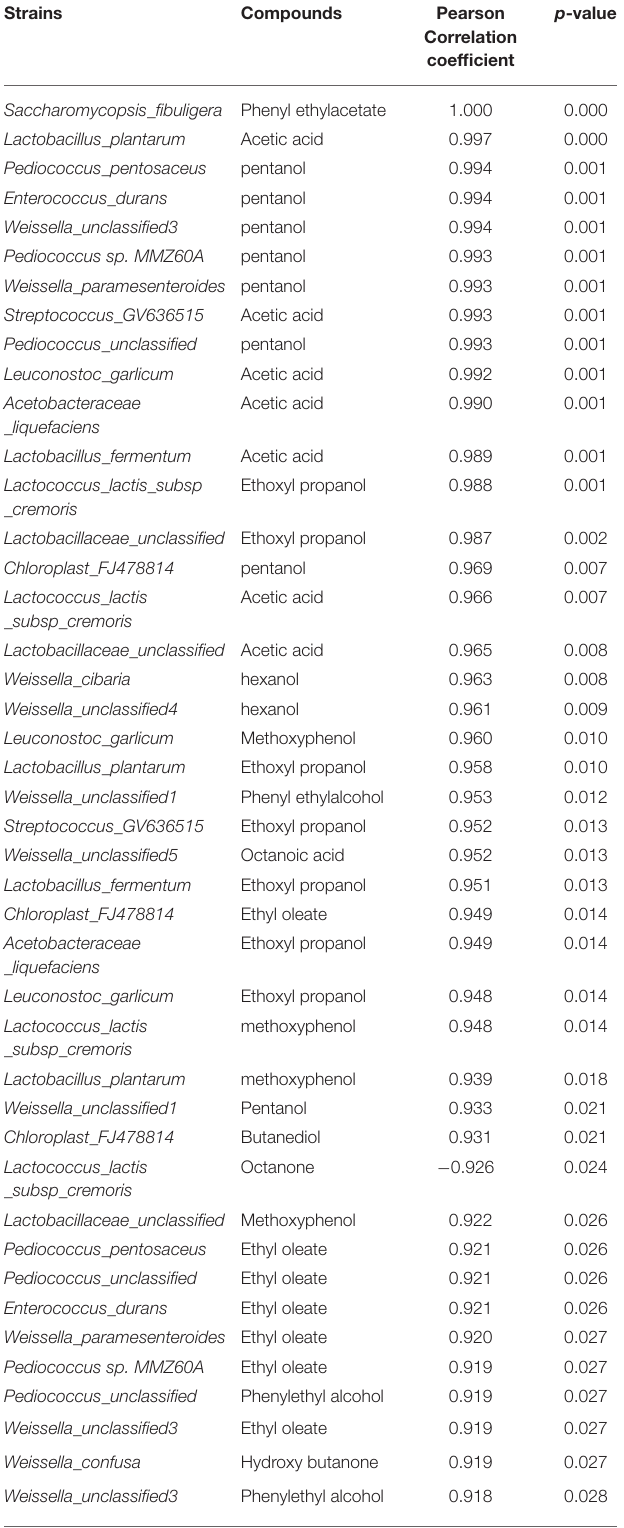
TABLE 4 | Correlation between the volatile compounds produced by each dried starter and bacteria and fungi species presented in each starter. Strains Compounds Pearson